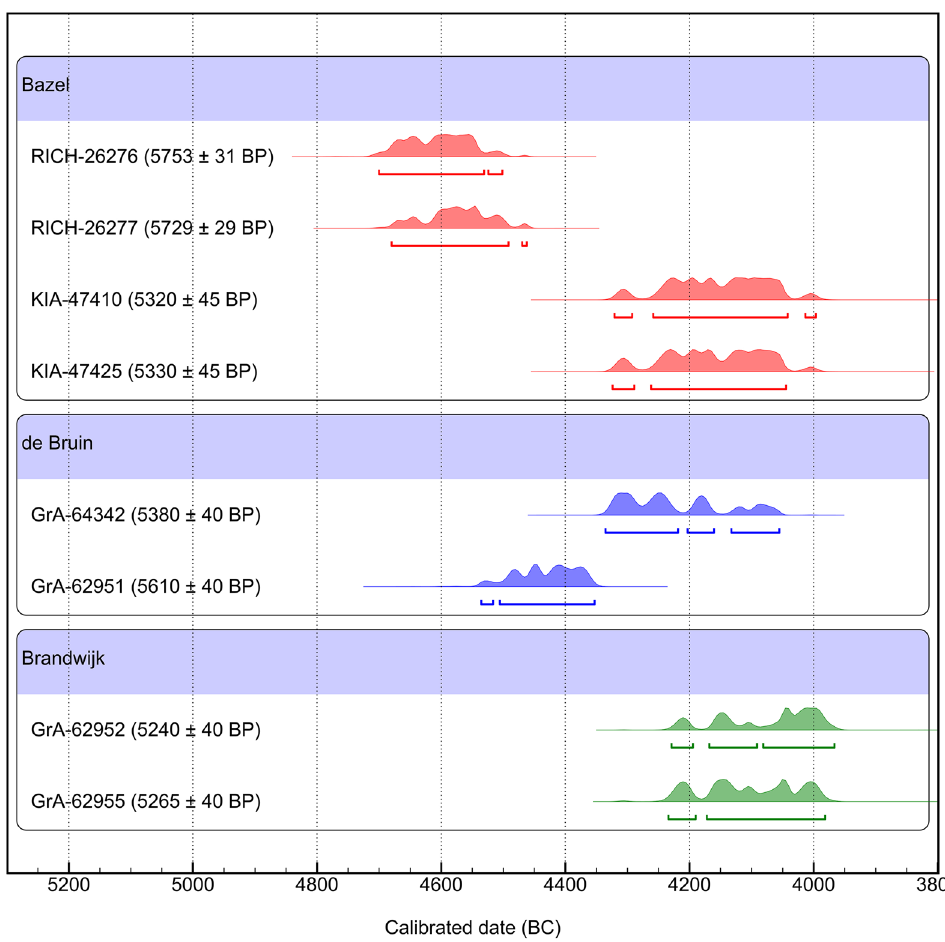
Figure 2. Probability distributions of radiocarbon dates of sheep/goat bones from Bazel Sluis, Hardinxveld- Giessendam de Bruin, and Brandwijk (OxCal v4.4.2 15 ). Dates and references are presented in Table 1.